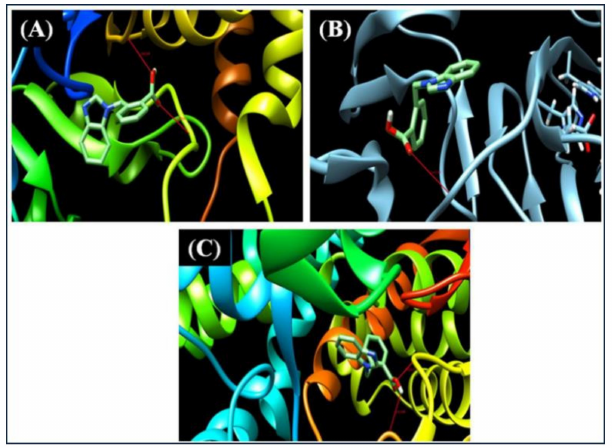
Figure 10. Molecule21HBMBA embedded in the active sites of ( A ) 3H4G ( B ) 4A7Y ( C ) 6M7X